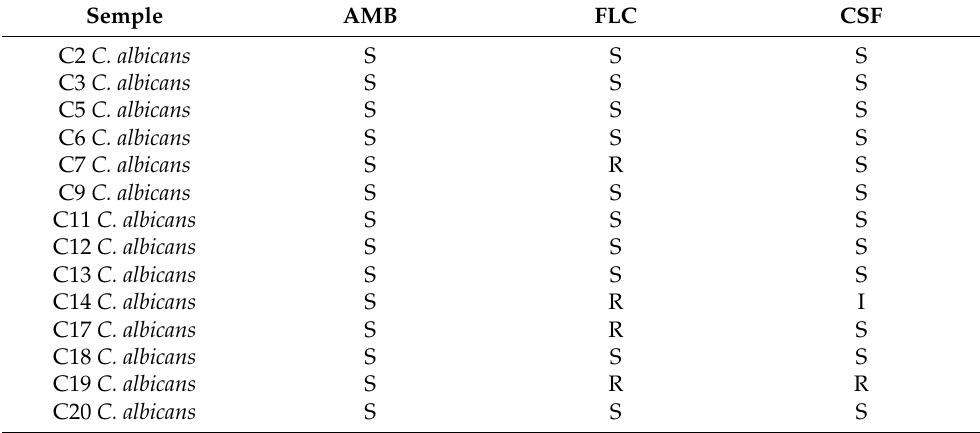
Table 3. Antifungal susceptibility of Candida albicans isolated from vulvovaginal candidiasis. AMB = amphotericin B; FLC = fluconazole; CSF = caspofungin; S = sensitive; I = intermediate; R =